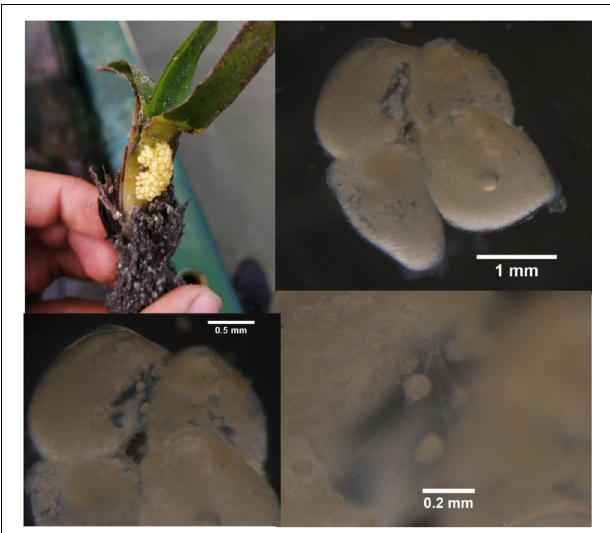
FIGURE 3 | The eggs of Monetaria annulus attaching on the leaf sheath of Thalassia hemprichii with different scales collected from Li’an gang, Hainan Island.